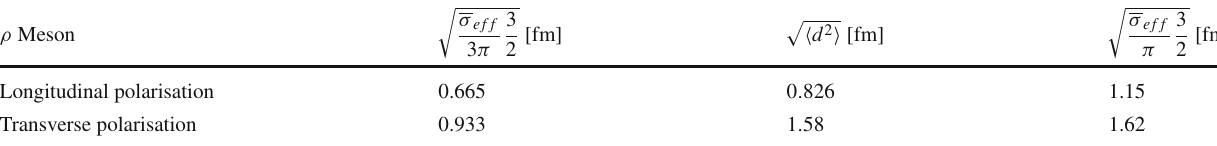
Table 6 Check of the validity of the RC inequality (20) in 3-dimension for the ρ meson ρ